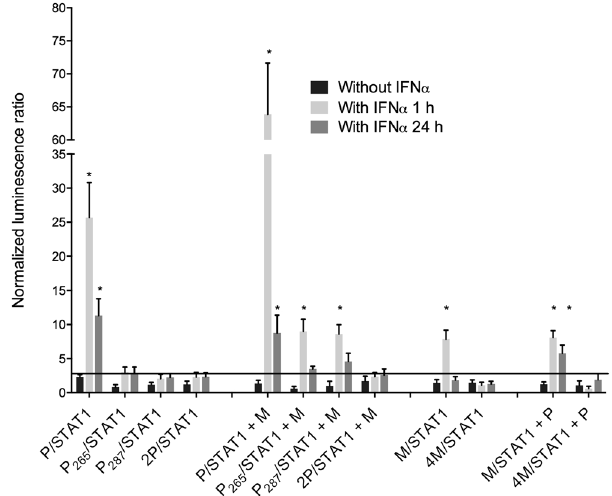
Figure 2. RABV P and/or M proteins cooperate in pSTAT1 interactions. Protein complementation assay: wild-type RABV or RABV with mutated P (P 265 , P 287 , 2P) or M (4M) proteins were co-transfected with STAT1- coding plasmid and stimulated for 1 or 24 h with or without IFN α . Two days post-transfection, Gaussia luciferase activity, whose intensity is indicative of interaction of the proteins, was determined. P and M proteins were also transfected as third partners in some experiments. All results are expressed as the means ± standard deviation (T-bars) of at least four independent experiments. * p < 0.05 compared to unstimulated